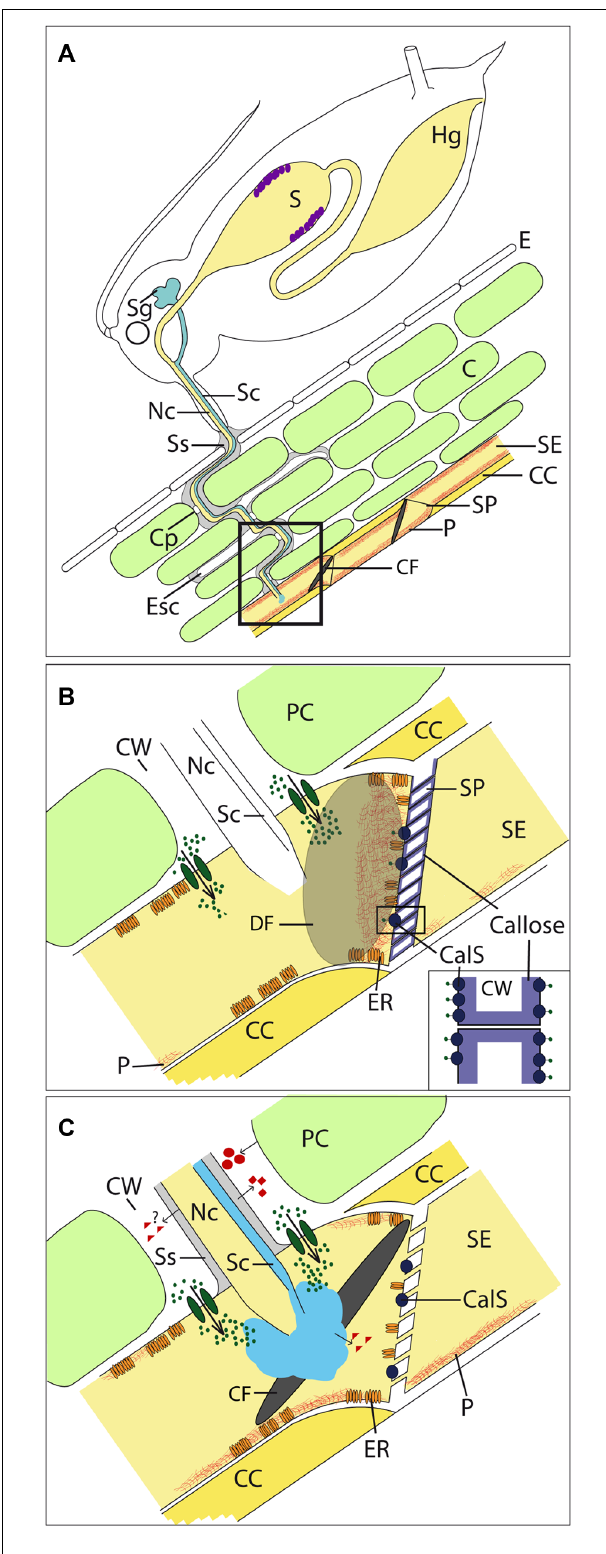
FIGURE 1 | Interaction of plants and aphids. (A) Aphids penetrate the plant with their stylet and move it through the apoplast toward the